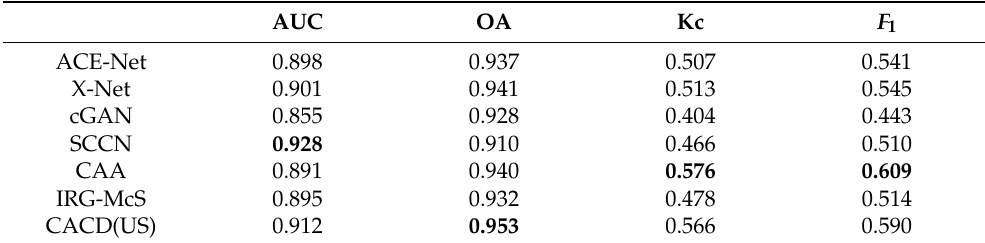
Table 1. Quantitative evaluation on the California dataset.